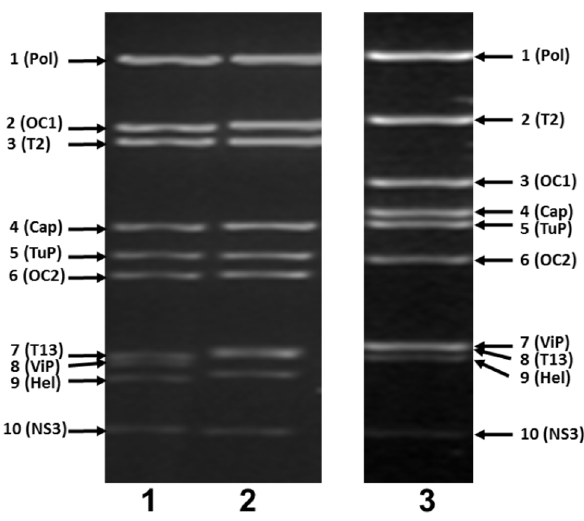
Figure 1. Agarose gel (1%) electrophoresis for dsRNAs of CORV, BTV and EHDV. The purified genomic RNA of LIB2007/07